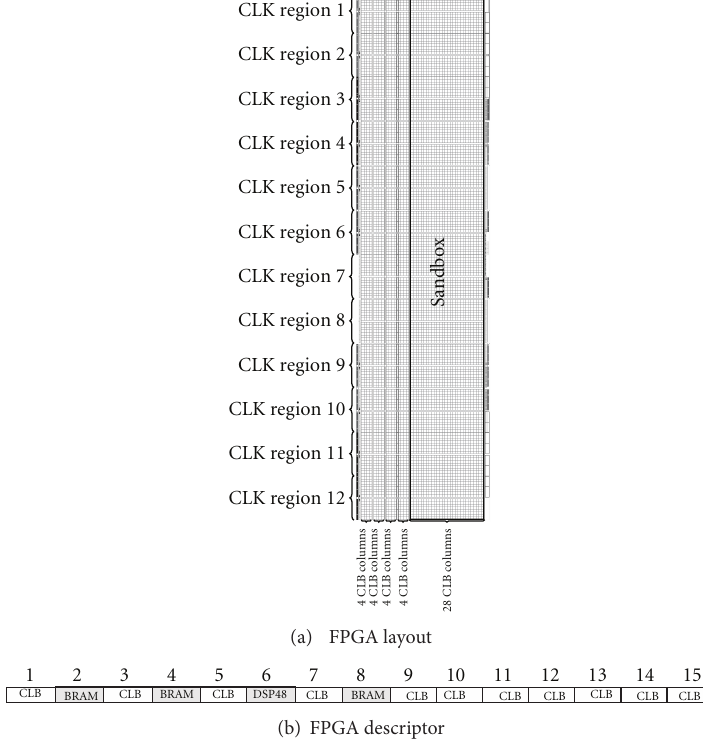
Figure 12: Left half part of the simulated XC4VLX160